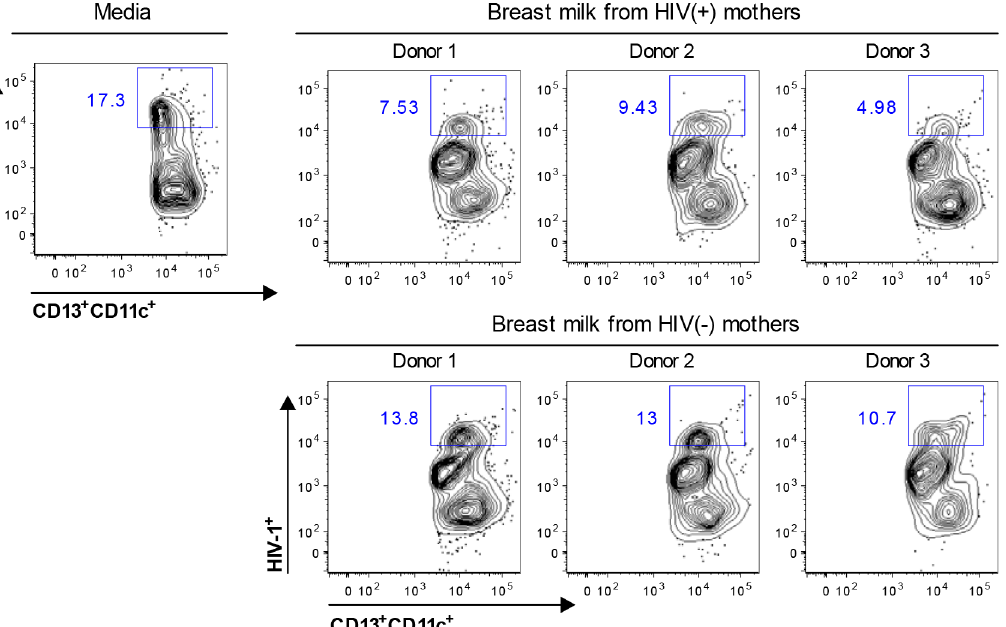
Fig 3. Breast milk impacts myeloid DC uptake and transport of HIV-1 through intestinal mucosa. Ugandan subtype A HIV-1 was pre-incubated with skimmed breast milk (diluted 1:2) for 30 min, applied to the apical surface of explanted intestinal mucosa. After 2 hr, cells in the lower chamber of the explant system were harvested and analyzed by flow cytometry by gating on myeloid DCs (CD13 + CD11c + ) that contained HIV-1 using KC57-FITC. Results are representative of experiments with two tissue